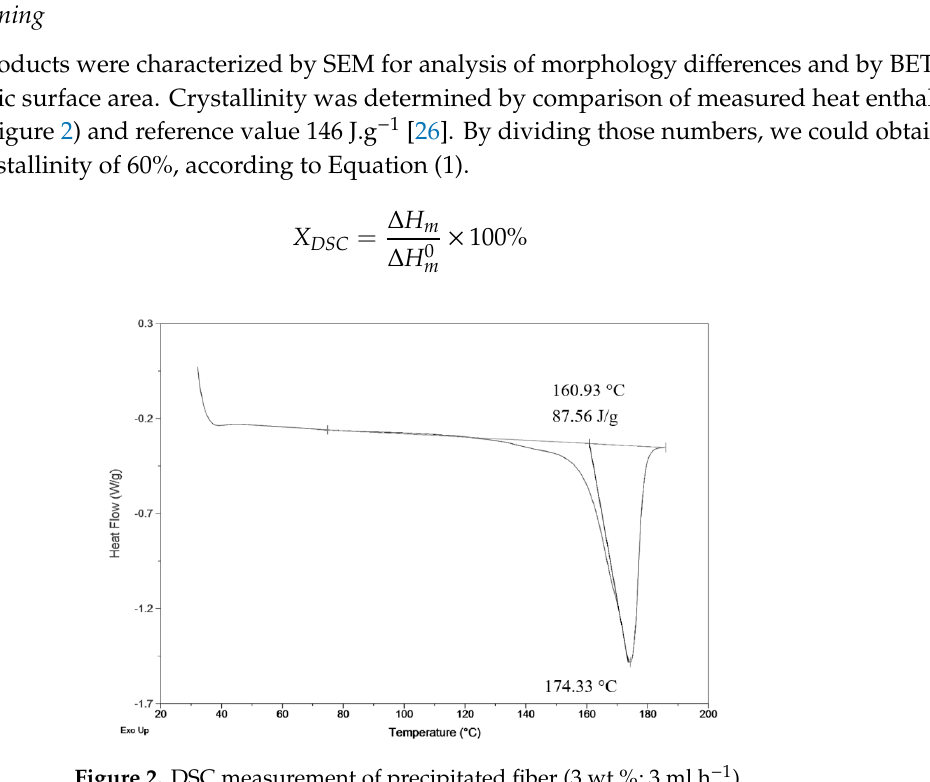
Figure 2. DSC measurement of precipitated fiber (3 wt.%; 3 ml.h − 1 ).